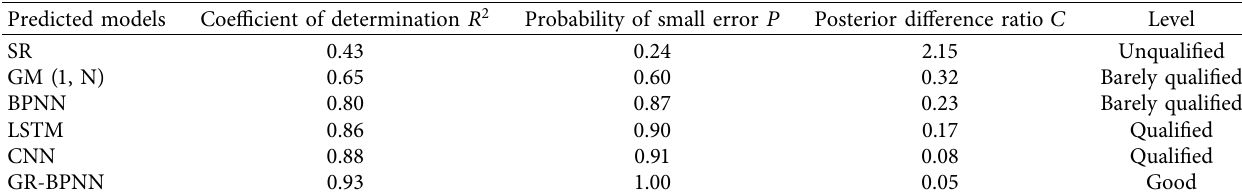
Table 3: Evaluation index of the precision grade of grain yield prediction model.